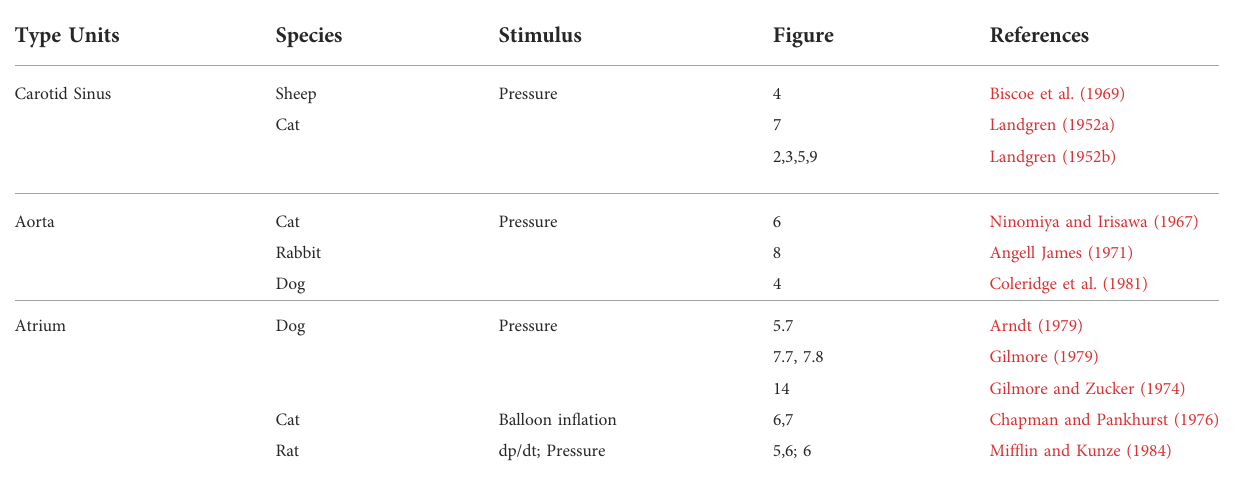
TABLE 1 Mechanosensory